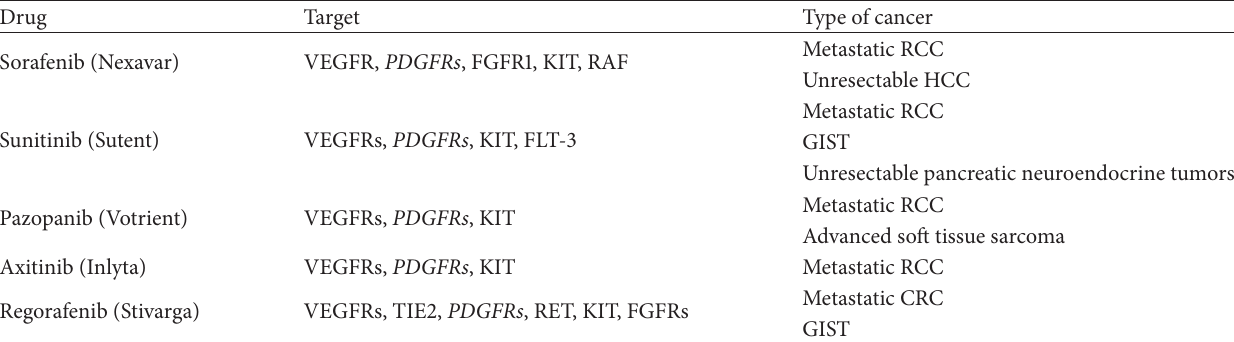
Table 2: Agents approved as